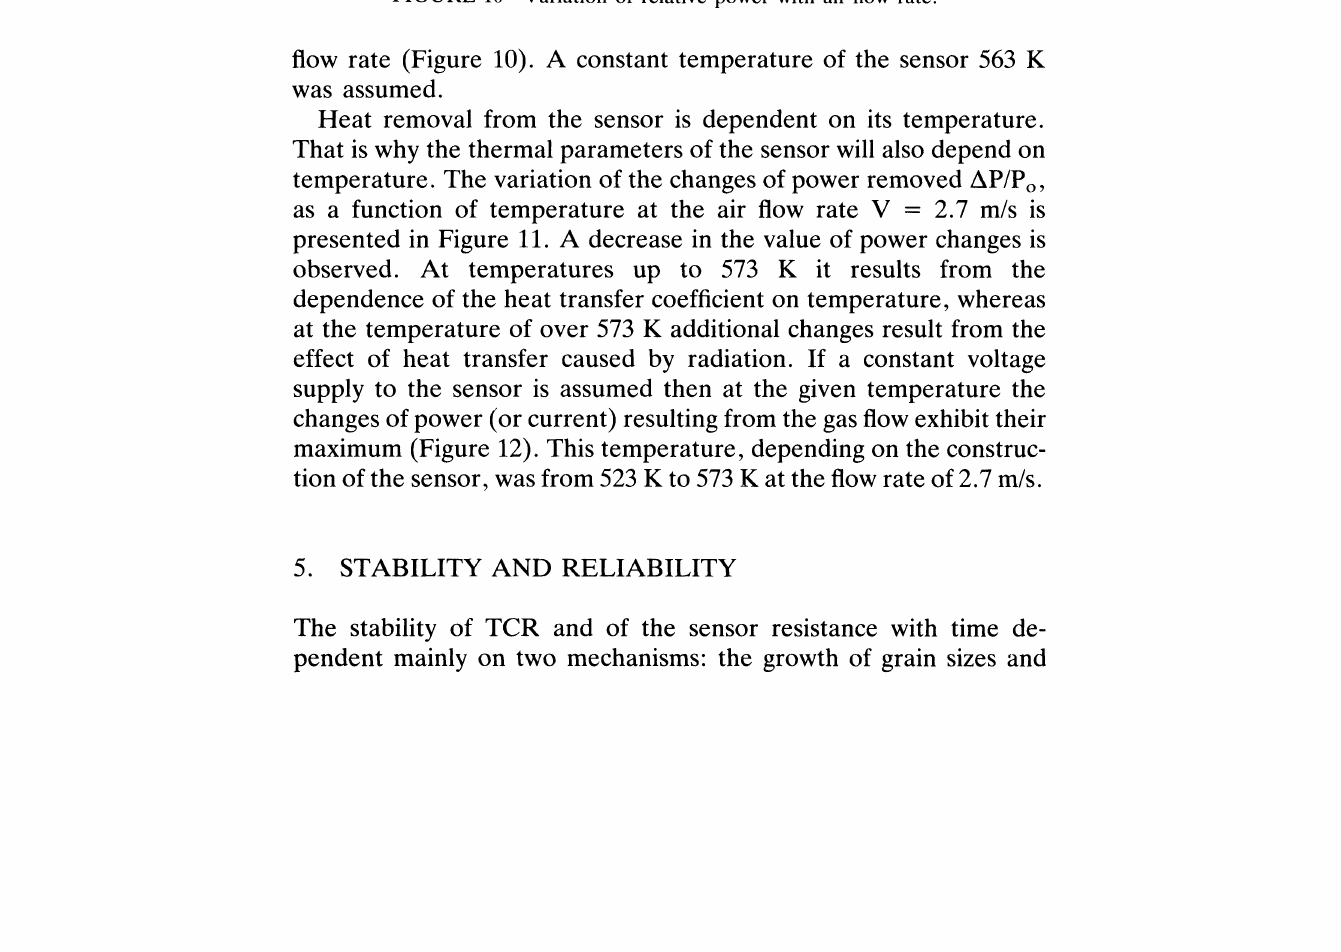
FIGURE 10 Variation of relative power with air-flow